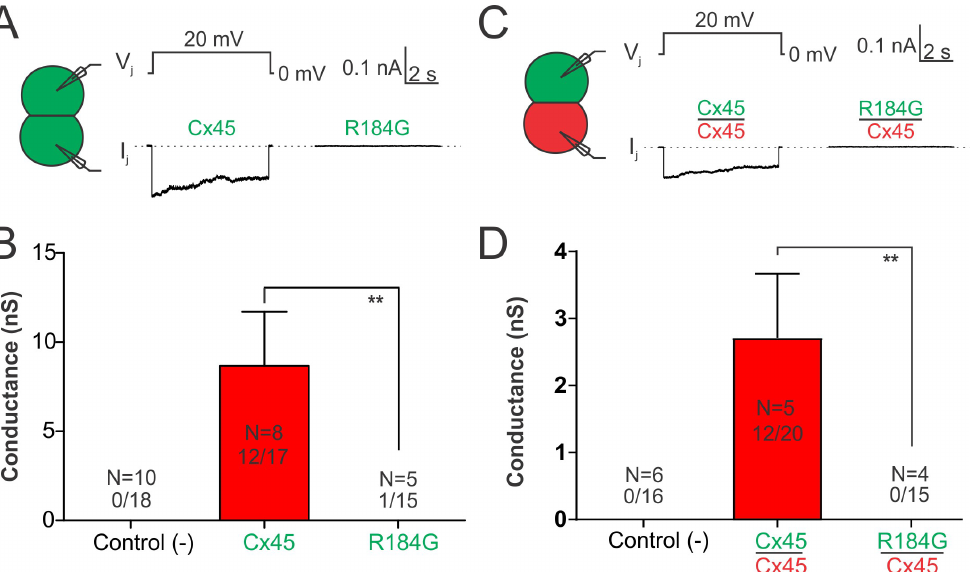
Figure 3. Impaired coupling conductance (G j ) of homotypic Cx45 R184G GJ channels in N2A cells. ( A ) Representative current recordings on N2A cell pairs that expressed Cx45 R184G showed no trans-junctional current (I j ) in response to a trans-junctional voltage (V j )-pulse; in contrast, cell pairs